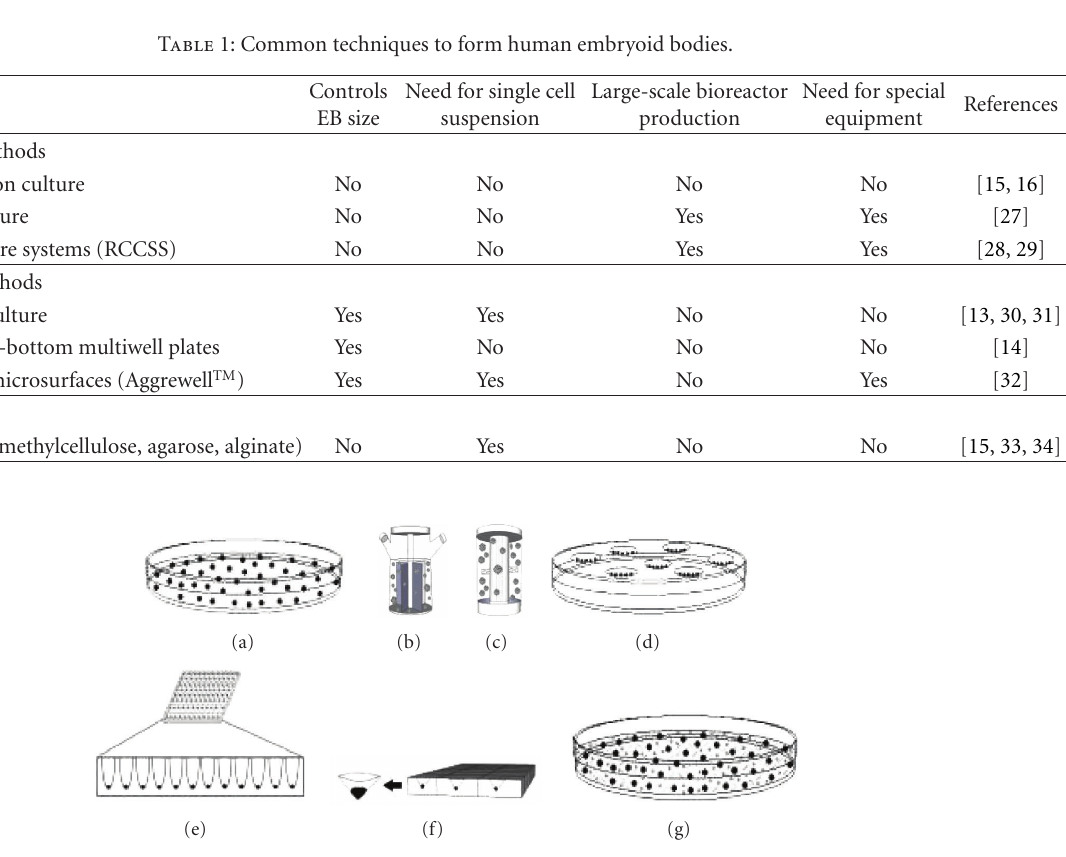
Figure 1: Schematic representation of methods to form embryoid bodies from pluripotent stem cells includes (a) liquid suspension culture, (b) stirred flask culture, (c) rotary cell culture systems, (d) hanging drop culture, (e) low adhesion U-bottom multiwall plates, (f) indented solid microsurfaces, and (g) hydrogel culture